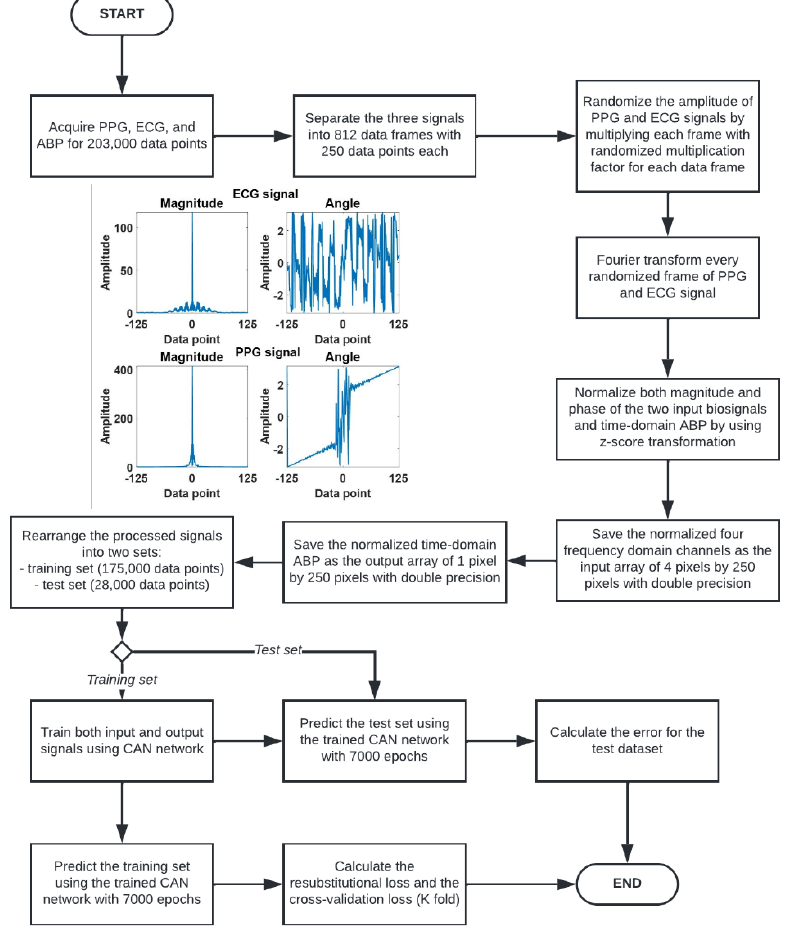
Figure 3. Flowchart describing signal preconditioning process and the network performance analy- sis.